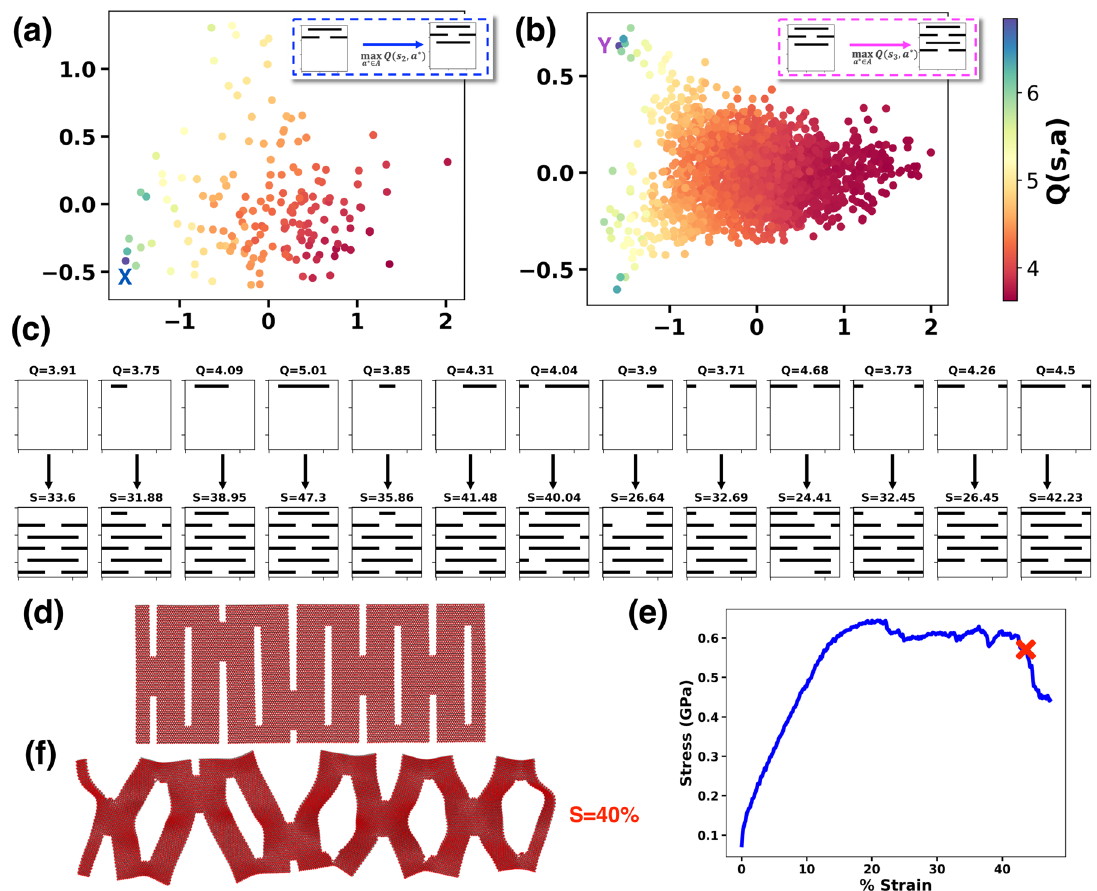
Fig. 5 Mechanistic insight of kirigami design learned by RL agent and zero-shot prediction of 10-cut structures. a , b Principal component analysis (PCA) of the learned features of the intermediate states at time t = 2 ( a ) and time t = 3 ( b ) by the RL agent that has maximum Q ( s t a ), where each of these states are colored by that Q ( s t , a ) value. State-action pair that has maximum Q ( s t , a ) is also highlighted in ( a ) and ( b ). c All possible cut choices to place a cut inside the material at t = 1 and the associated Q ( s , a ) for that state-action pair. It also shows a proposed structure along with its stretchability by the RL agent for each of the associated action taken at t = 1 and then afterward following the RL policy. d zero-shot prediction of kirigami structures with n = 10. e Stress – strain curve computed by MD simulation and f atomic structure of the system just above 40% strain (red